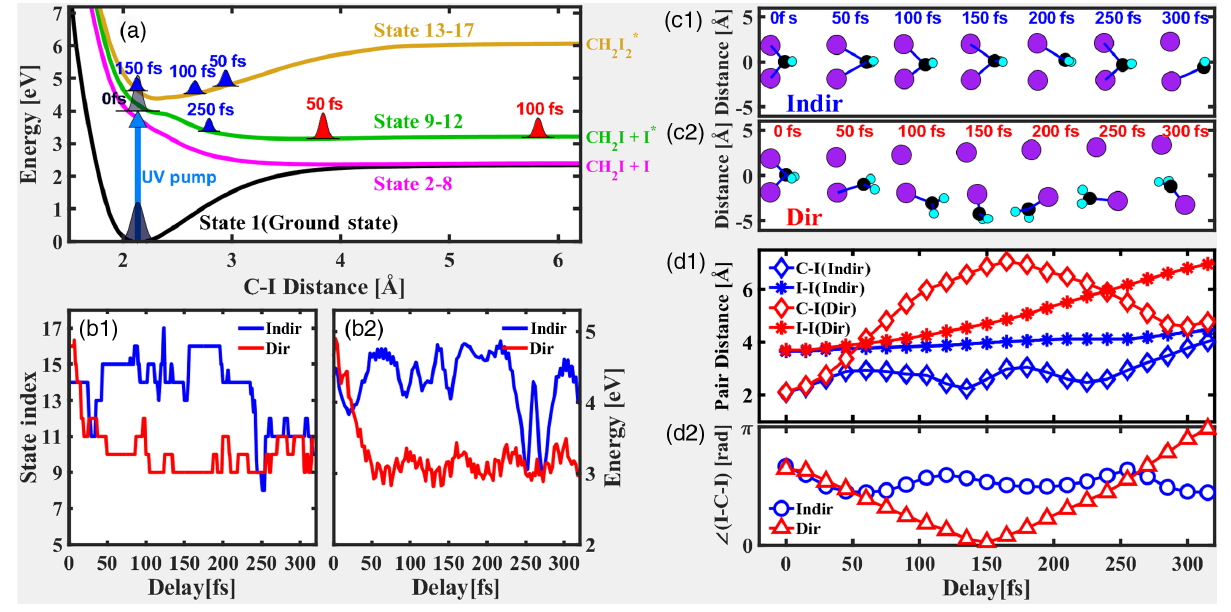
FIG. 5. Spectroscopic and structural views of CH 2 I 2 dissociation dynamics. (a) Potential energy curves and cartoon snapshots of the wave packet at different time delays for indirect dissociation (blue) and direct dissociation (red) trajectories. (b1) Time-evolved electronic state index for indirect (blue) and direct (red) dissociation trajectories. (b2) Time-evolved potential energy for indirect (blue) and direct (red) dissociation trajectories. (c1) Snapshots of the molecular structure at different time delays for an indirect dissociation trajectory. (c2) Snapshots of the molecular structure at different time delays for a direct dissociation trajectory. The frames show 2D projections of the 3D molecule onto the I-C-I plane. (d1) Time evolution of pair distances for indirect (blue) and direct (red) dissociation trajectories. (d2) Time evolution of the I-C-I angle from the indirect and direct dissociation